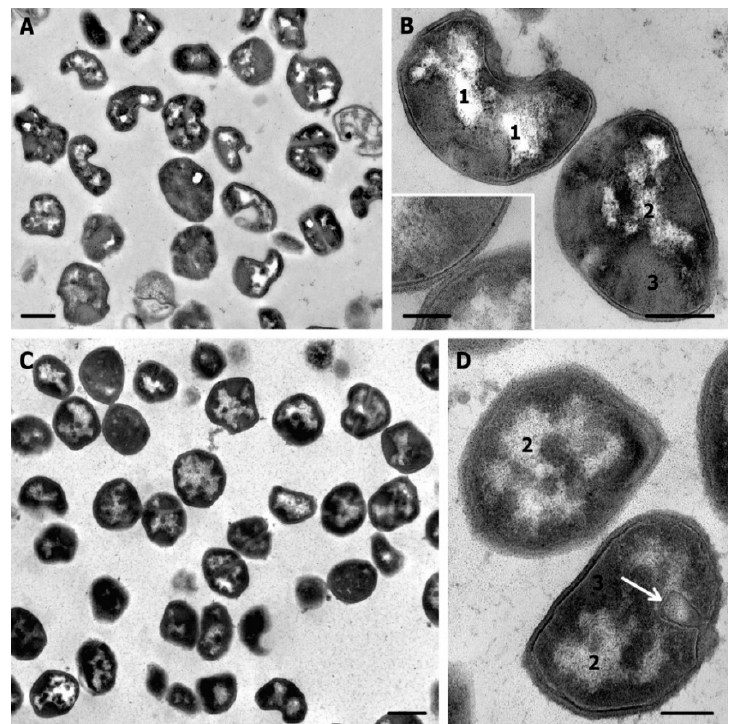
Figure 5. Ultrastructure of S. aureus cells incubated for 30 min with peptides R9F2 ( A , B ) and (KFF)3K ( C , D ). Insert: two cells, demonstrating “normal” cell walls. 1—“empty” areas, 2—areas filled with fine grains; 3—coagulated structureless cytoplasm. Arrow shows mesosome formation. TEM of ultrathin sections. Scale bars correspond to: ( A , C )—500 nm, ( B , D )—200 nm, inset—100